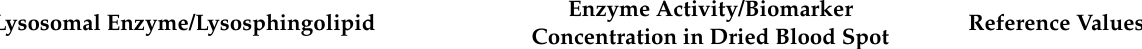
Table 1. Results of lysosomal enzymes activity and lysosphingolipids concentration in dried blood spot of the reported